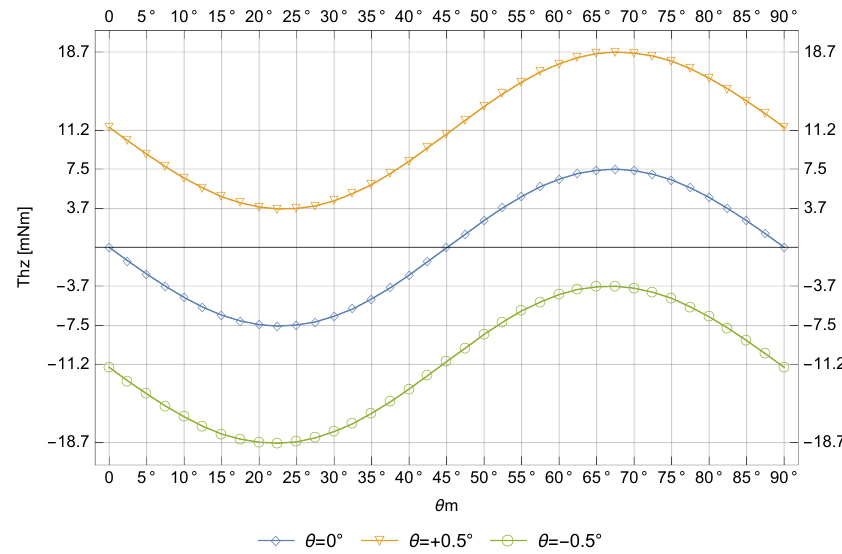
Figure 6. Propeller torque variation simulations in function of θ m for α max , for θ = − 0.5 ◦ , 0 ◦ and 0.5 ◦ . ) , i.e., when the magnets are closest, It is possible to see that T h is null only if θ h = θ m = 0 ( mod π 2 z ( mod π ) (unstable). Out of e.g., as presented in Figure 2 (stable), or in the midway with θ h = θ m = π 4 2 these points for θ = 0 ◦ , the Flat-RMCT presents not null torques because rotors are not completely geometrically axisymmetric and the system always tends towards MMR positions. These torque ( mod π ) (since 22.5 ◦ is a midpoint between two MMR positions), values are extreme for θ h = θ m = π 8 4 with a sinusoidal variation which has an amplitude equal to 7.5 mNm (for α max ) and argument equal to 4 θ m (or 4 θ h , since θ = 0 ◦ ), due to the four magnets pairs. This torque variation ∆ T z ( α , θ m or h ) can be named auto-driving effect (Equation (3)), which is identical for both rotors when θ is null, i.e., ( θ = 0 ) (Equation (4)), driving them in the same direction. Its amplitude is the ( θ = 0 ) = T T m h z z ( α ) . For this condition we can write same for other θ angles, depending only on α , thus named A ∆ T z Equations (3) and